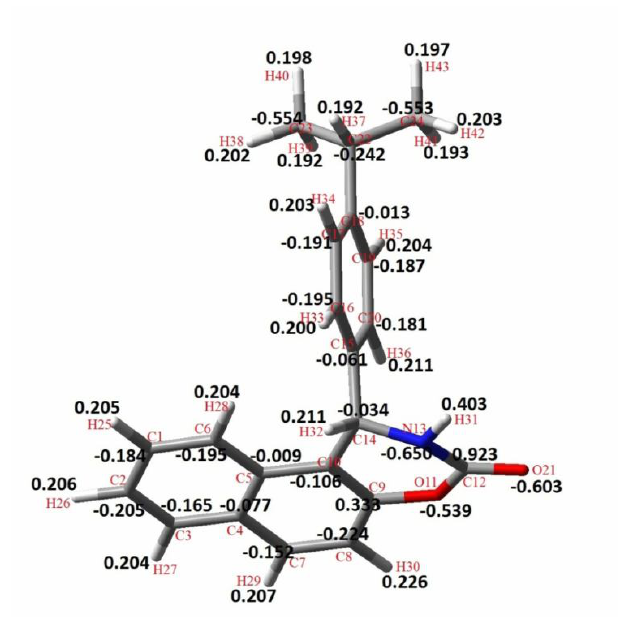
Fig. 7. Calculated (B3LYP/6-311+G*) natural charges (NBO) of the atoms of 4i molecule. (The Cartesian coordinates of the optimized structure are available in the supplementary